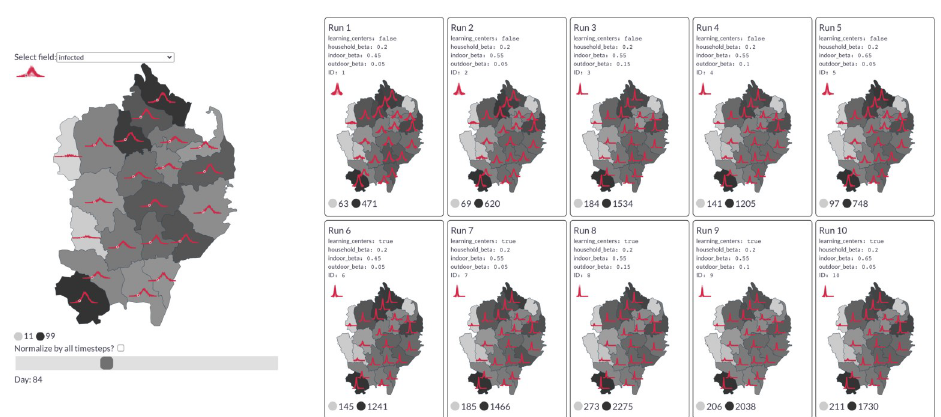
Fig 4. Left: An example from the dashboard showing daily infections by region for a single simulation. The red sparklines indicate the trend over the course of the whole simulation. The slider position marks 84 days after the start of simulation (i.e., the current time step). Darker regions indicate a higher infection count at this point in time. Right: Comparison of the daily infection rate of each region across 10 simulations of the “learning centers” scenario, colored by the peak infection rate seen in each region. Basemaps from